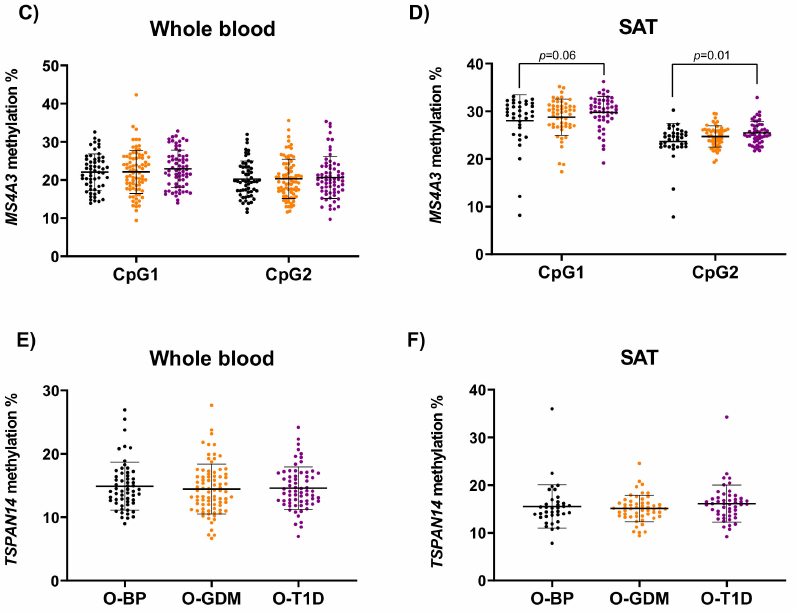
Figure 3. Methylation at target CpG sites associated with ESM1 , MS4A3 , and TSPAN14 in whole blood ( A , C , E ) and subcutaneous adipose tissue (SAT) ( B , D , F ). Bars represent mean ( ± SD). p -values repre- sent difference between offspring groups and were calculated by multivariate regression modelling, including the covariates of maternal diabetes status, maternal pre-pregnancy BMI, and offspring sex. Black dots indicate O-BP, orange dots indicate O-GDM, and purple dots indicate O-T1D. O-GDM: offspring of women with GDM, O-T1D: offspring of women with T1D, O-BP: offspring of women from the background